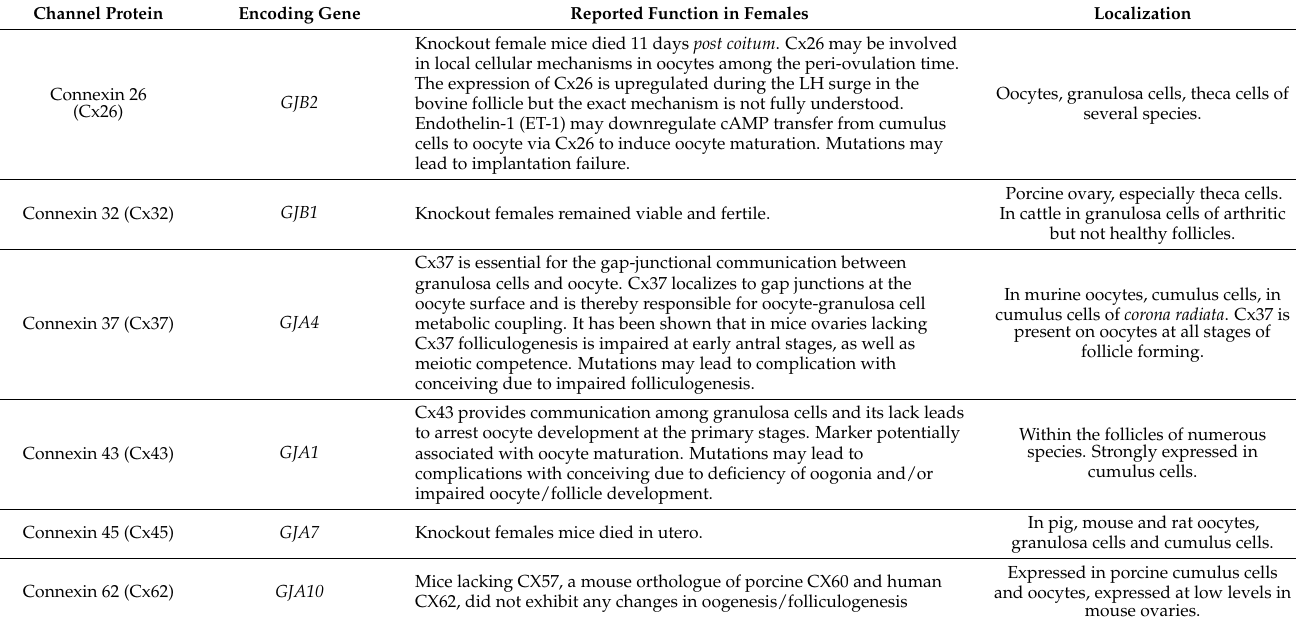
Table 1. Connexins involved in oocyte development and female fertility. See text for references. Channel